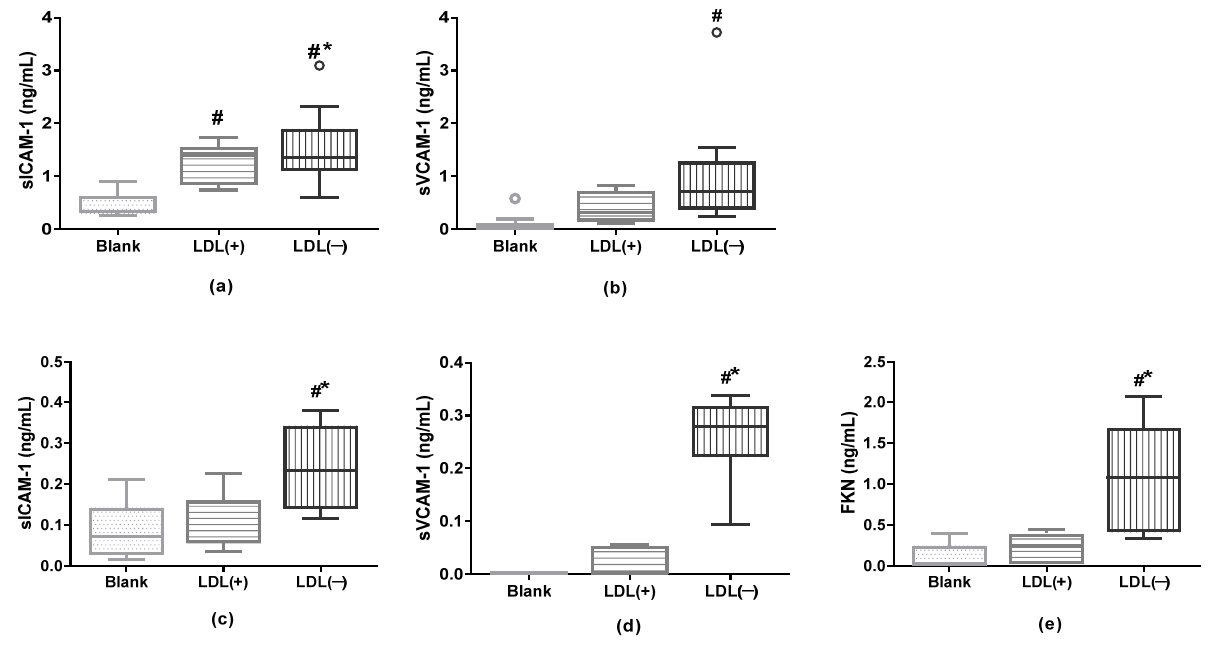
Figure 5. LDL( − )-induced release of inflammatory molecules in macrophages and endothelial cells. THP1-CD14 macrophages (400,000 cells/well) and HCAEC (50,000 cells/well) were incubated in the presence or absence of LDLs (60 mg apoB/L) for 24 h. sICAM-1, sVCAM-1, and FKN release were then evaluated by ELISA in the supernatant of ( a , b ) THP1-CD14 macrophages (n = 11) and of ( c – e ) HCAEC (n = 7). The Kruskal–Wallis test was performed ( p < 0.01 in all cases), # vs. Blank; * vs. LDL(+); p < 0.05.